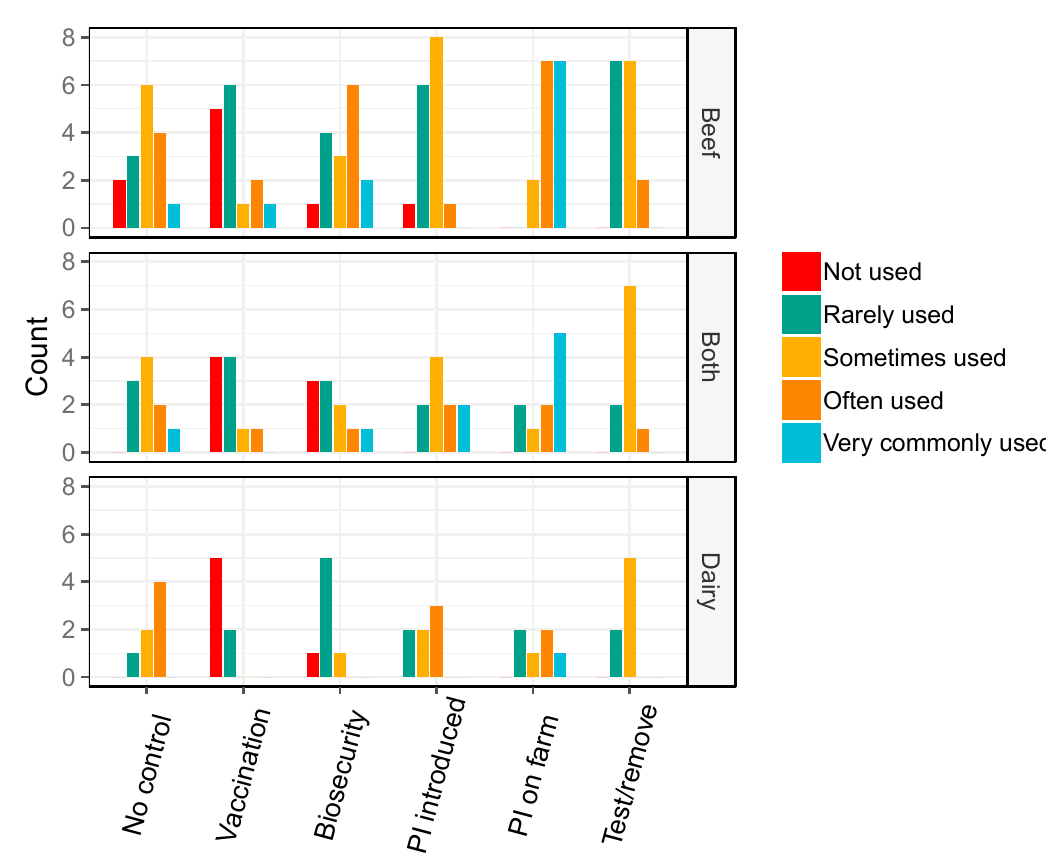
Figure 4. Barplots of the frequency of management practices used on bovine viral diarrhoea virus (BVDV) positive properties reported by veterinarians, in a survey of veterinarians’ knowledge, attitudes and practices associated with BVDV management on properties in the temperate climate zone of south-east Australia in 2019. PI = persistently infected cattle. Both = veterinarians working with both beef and dairy properties.